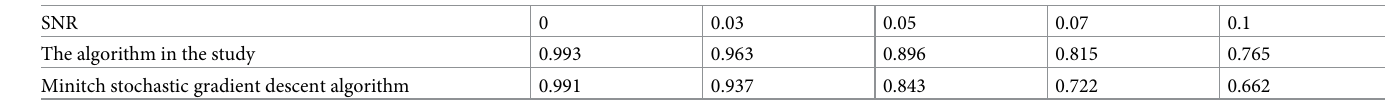
Table 4. Comparison of image recognition performance under different